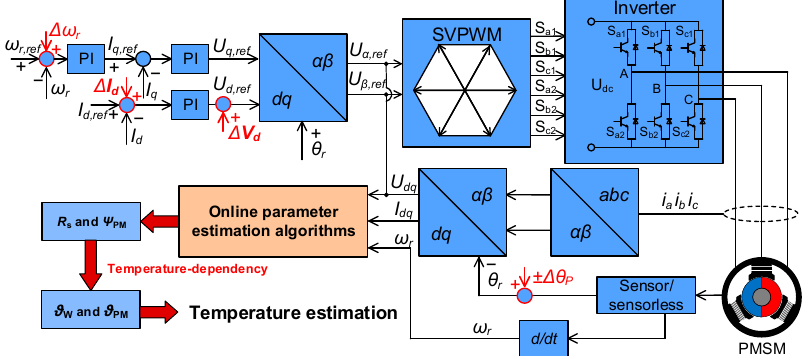
Figure 34. Schematic diagram of electrical parameter-based temperature estimation.